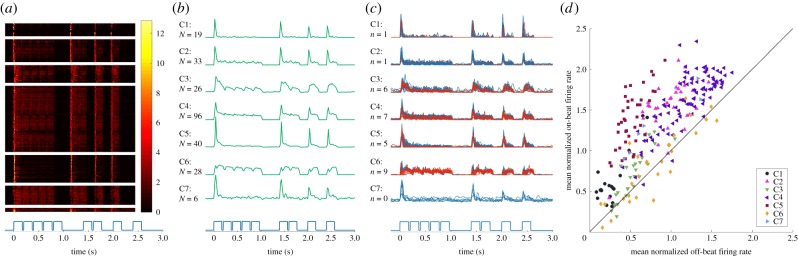
Clustering analysis. (a) Heat map illustrating each unit's normalized firing rate in response to one cycle of pattern P2 at 1× tempo. Units are grouped by cluster. The stimulus pattern is plotted beneath each panel for reference. (b) Each cluster's mean PSTH, with the total number of units in each cluster (N) displayed to the left of each trace. (c) Mean PSTH traces of multi-units (blue) and single units (red) in each cluster. The number of single units (n) is displayed to the left. (d) Same as figure 1d, but with units labelled by the cluster to which they belong.